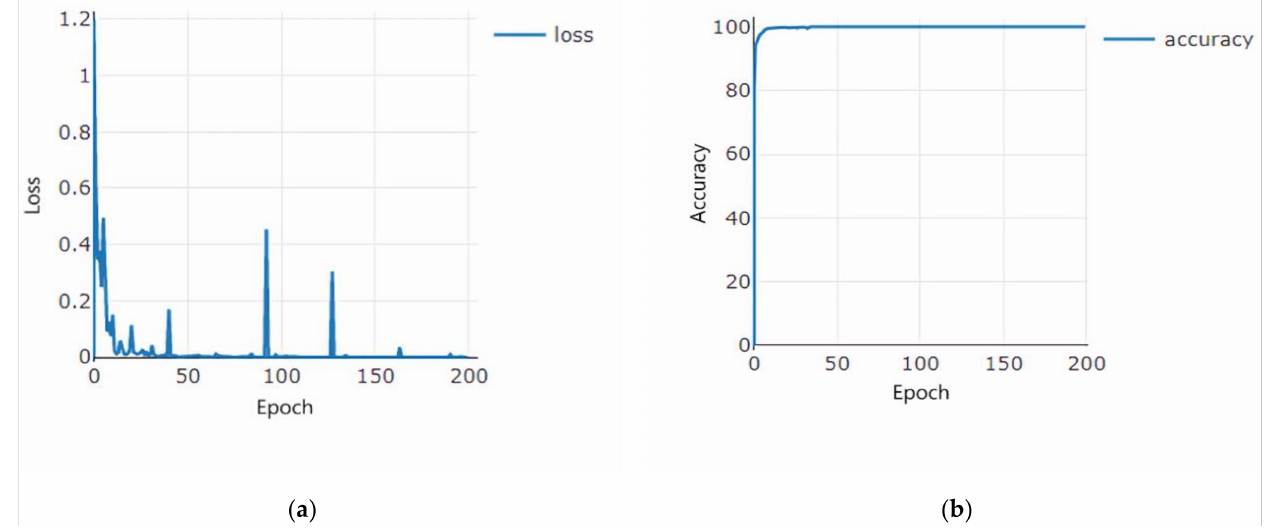
Figure 10. Performance of first data set. ( a ) loss (%), ( b ) accuracy (%).